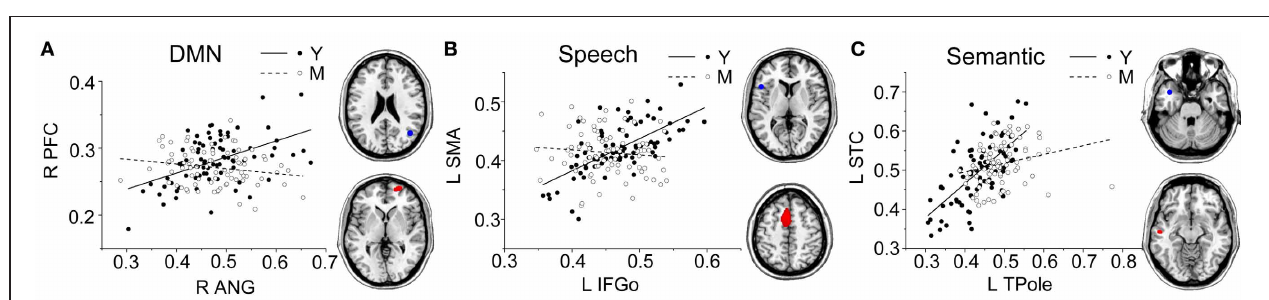
FIGURE 4 | Group differences for the young vs. the middle-aged subjects. Significant between-group differences within the DMN (A) , speech (B) , and semantic (C) structural covariance networks were found. For each network, the region of interest (upper) and region showing the most significant structural association (lower) are presented on the right, and a plot of slop differences between the seed region and a 4-mm radius